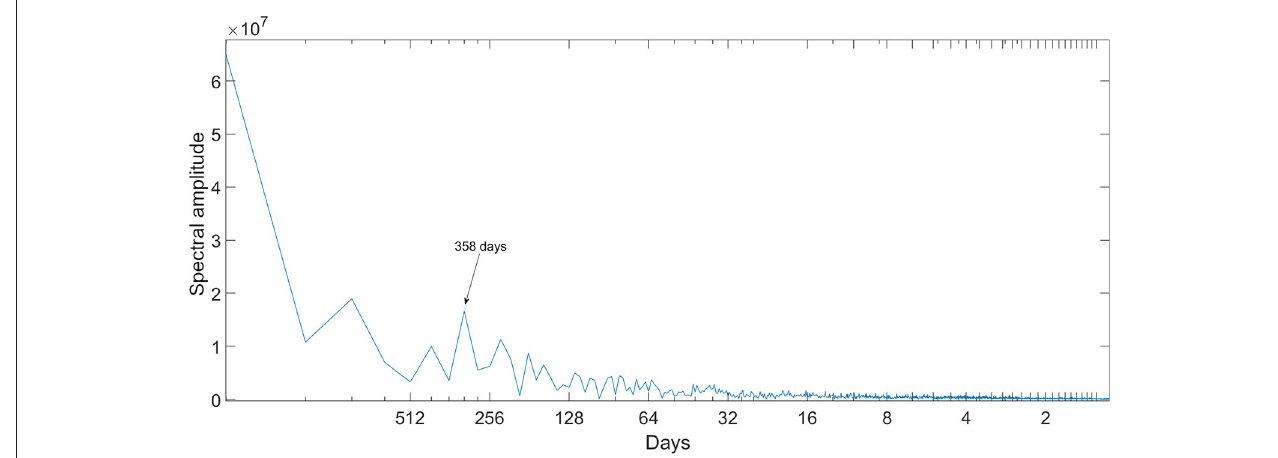
FIGURE 6 | Amplitude spectrum showing the low-frequency peaks for the entire monitored period of the observed soil CO 2